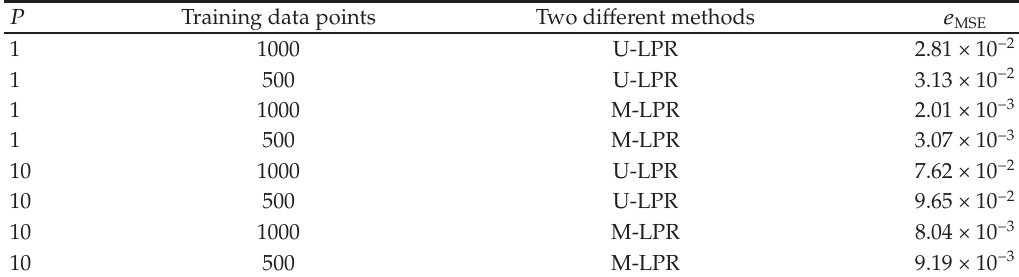
Table 2: MSE using both